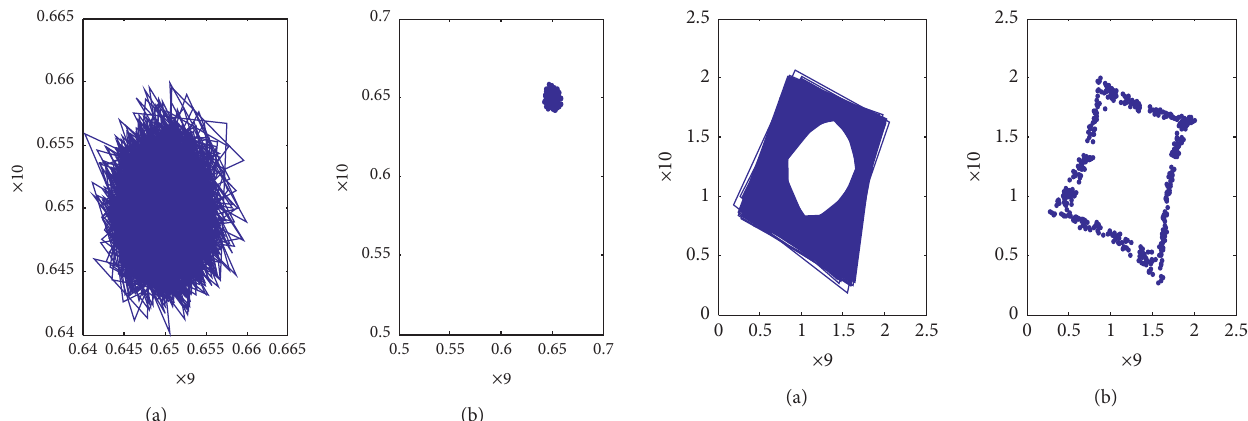
Figure 43: ω � 238 with random perturbation.